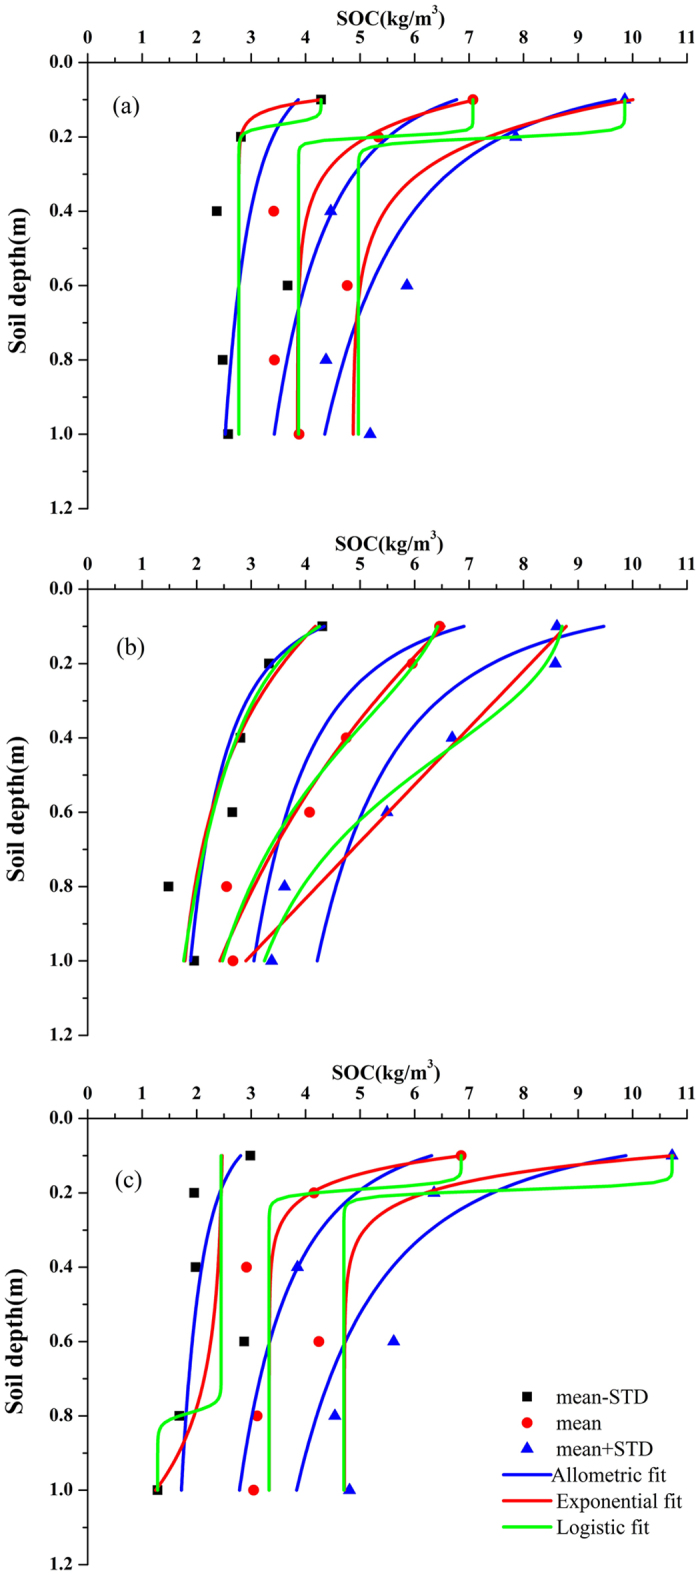
Fitting curves of vertical distribution of volumetric SOC (SOCv) using three functions in Phragmites australis salt marsh (PSM, (a)), Suaeda salus salt marsh (SSM, (b)) and Tamarix chinensis-Suaeda salus salt marsh (TSSM, (c)).